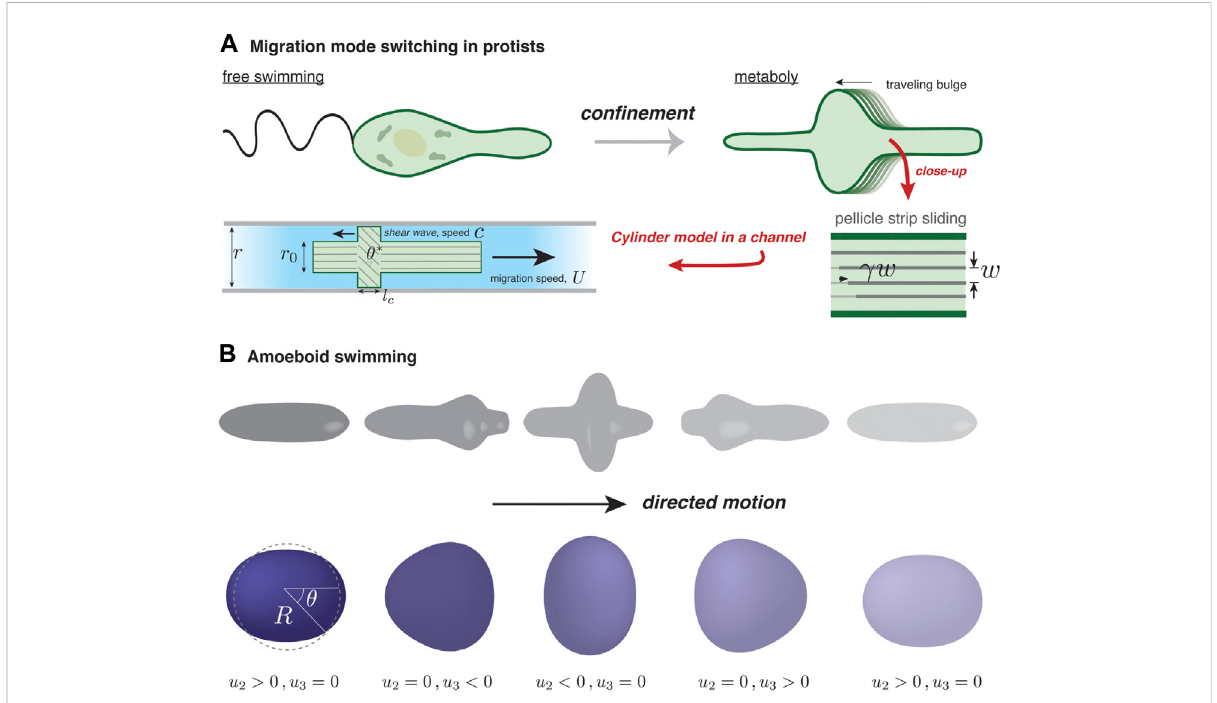
FIGURE 2 Self-deformation-basedmigration. (A) Dependingoncon fi nement,protistsfromthegenus Euglena canswimusinga fl agellumorinchforward using surface waves, a process known as metaboly. The rearward traveling surface bulges characterizing metaboly are generated by microtubule activityintheparallelstripsformingthepellicle,anorganismicenvelope.Thestripsareassumedtomaintaina fi xedseparation, w ,andinternalactivity generates a localized traveling pulse of relative strip sliding, γ Noselli et al. (2019). In the simple version of the model by Noselli et al. (2019), the con fi ned organism ismodeled asauniform cylinder ofradius r 0 , except overaregion where γ isnon-zero. There,and overalength l c , relativesliding induces tilting with respect to the channel axis and bulging of the surface to become in contact with the channel walls; the tilt angle is related to r 0 andthechannelradiusbycos θ *= r 0 / r .Intheframeofthemovingcylinder,thecontactzonemovesrearwardwithspeed c ;thecellspeed U depends solely on c and θ *. (B) Illustration of amoeboid swimming in a viscous fl uid (not shown). Actively generated forces at the cell surface are assumed to give rise to cyclic cell shape changes. In order to respect Purcell ’ s scallop theorem Purcell (1977), directed motion requires that a forward-played movie of a “ stroke ” cycle looks different than its backward-played version. A minimal reduction of amoeboid swimming is a superposition of two deformation modes, one with nematic symmetry ( l = 2) and another with polar symmetry ( l = 3). The surface displacement away from the spherical state, u ( θ , t ), is projected onto the two modes, with amplitude u 2 ( t ) and u 3 ( t